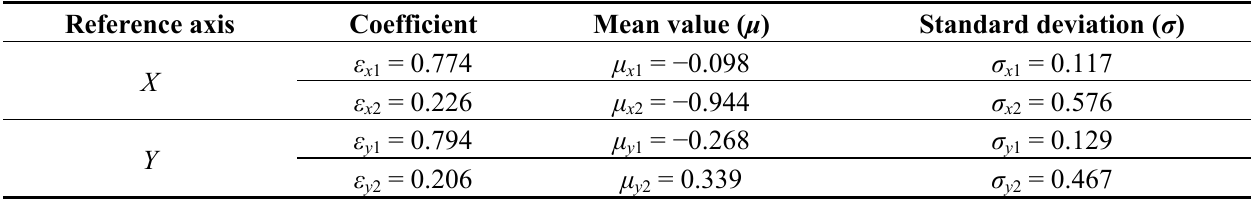
Table 6. The divided results of the fifth harmonic current.